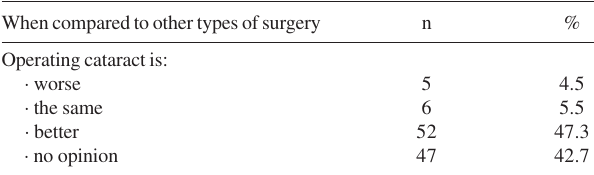
Table 4 - Importance attributed to cataract surgery (N =110) When compared to other types of surgery n % Operating cataract is: ·